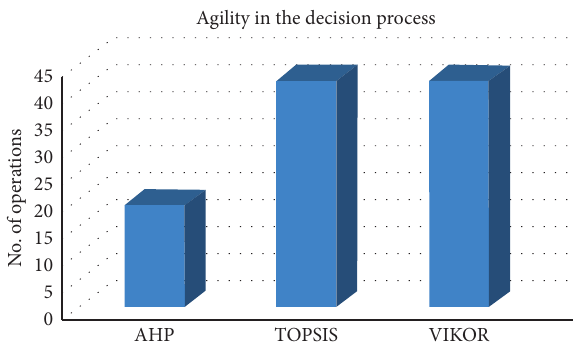
Figure 4: Agility in the decision process.